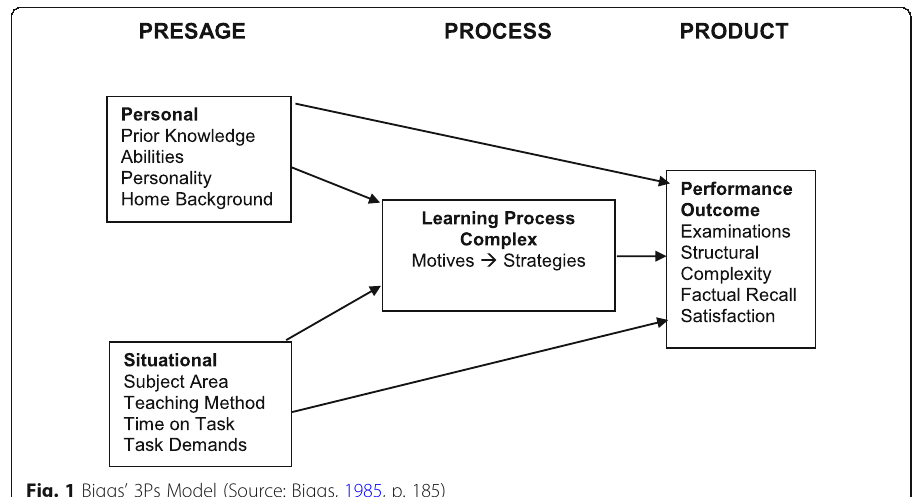
Fig. 1 Biggs ’ 3Ps Model (Source: Biggs, 1985, p.